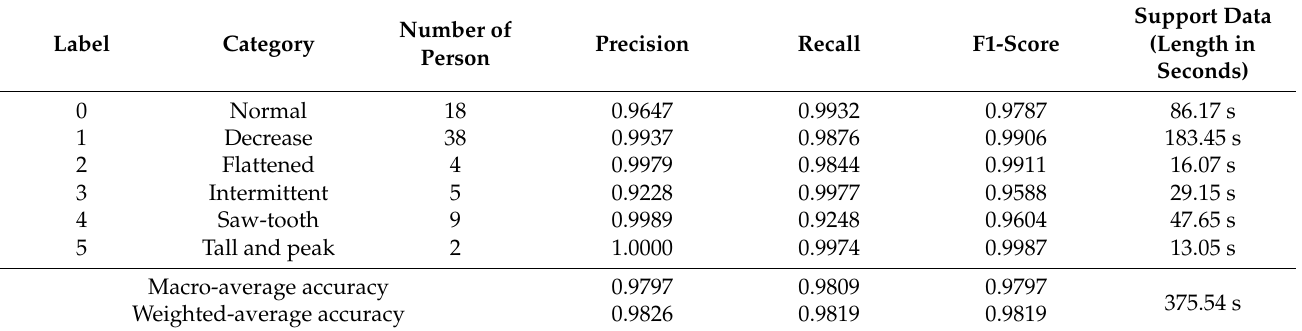
Table 1. The performance of urination patterns in data sets and evaluation indicators.